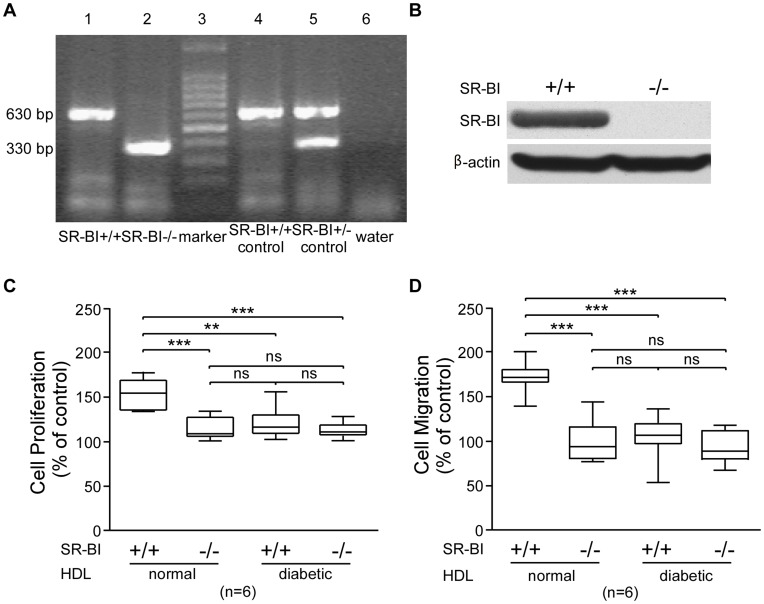
SR-BI mediates the effects of N-HDL on MAEC proliferation and migration. A)Representative agarose gel of SR-BI genotype assay by PCR. Lanes 1 and 2 are derived from 2 littermates from the offspring of SR-BI +/− parents. Lane 3 indicates molecular weight markers. Lanes 4 and 5 are derived from a wild type (SR-BI +/+) and a heterozygous (SR-BI +/−) individual. Lane 6 is negative control with water. B) Protein expression of SR-BI in liver from SR-BI (+/+) and SR-BI (−/−) mice was measured using western blot. C) MAECs from SR-BI (+/+) and SR-BI (−/−) mice were treated with N-HDL or D-HDL for 24 hours. Relative cell number was compared to untreated control cells using the MTT assay. Box-whisker plots of cell number are shown (**, p<0.01 by non parametric ANOVA test, n = 6). D) MAECs from SR-BI (+/+) or SR-BI (−/−) mice were treated with N-HDL or D-HDL for 8 hours and transwell migration assays were performed (***, p<0.001 by non parametric ANOVA test, n = 6).